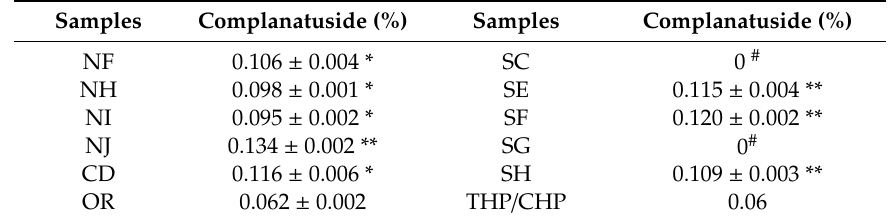
Table 4. The complanatuside content of 11 batches of commercial Astragali Complanatus